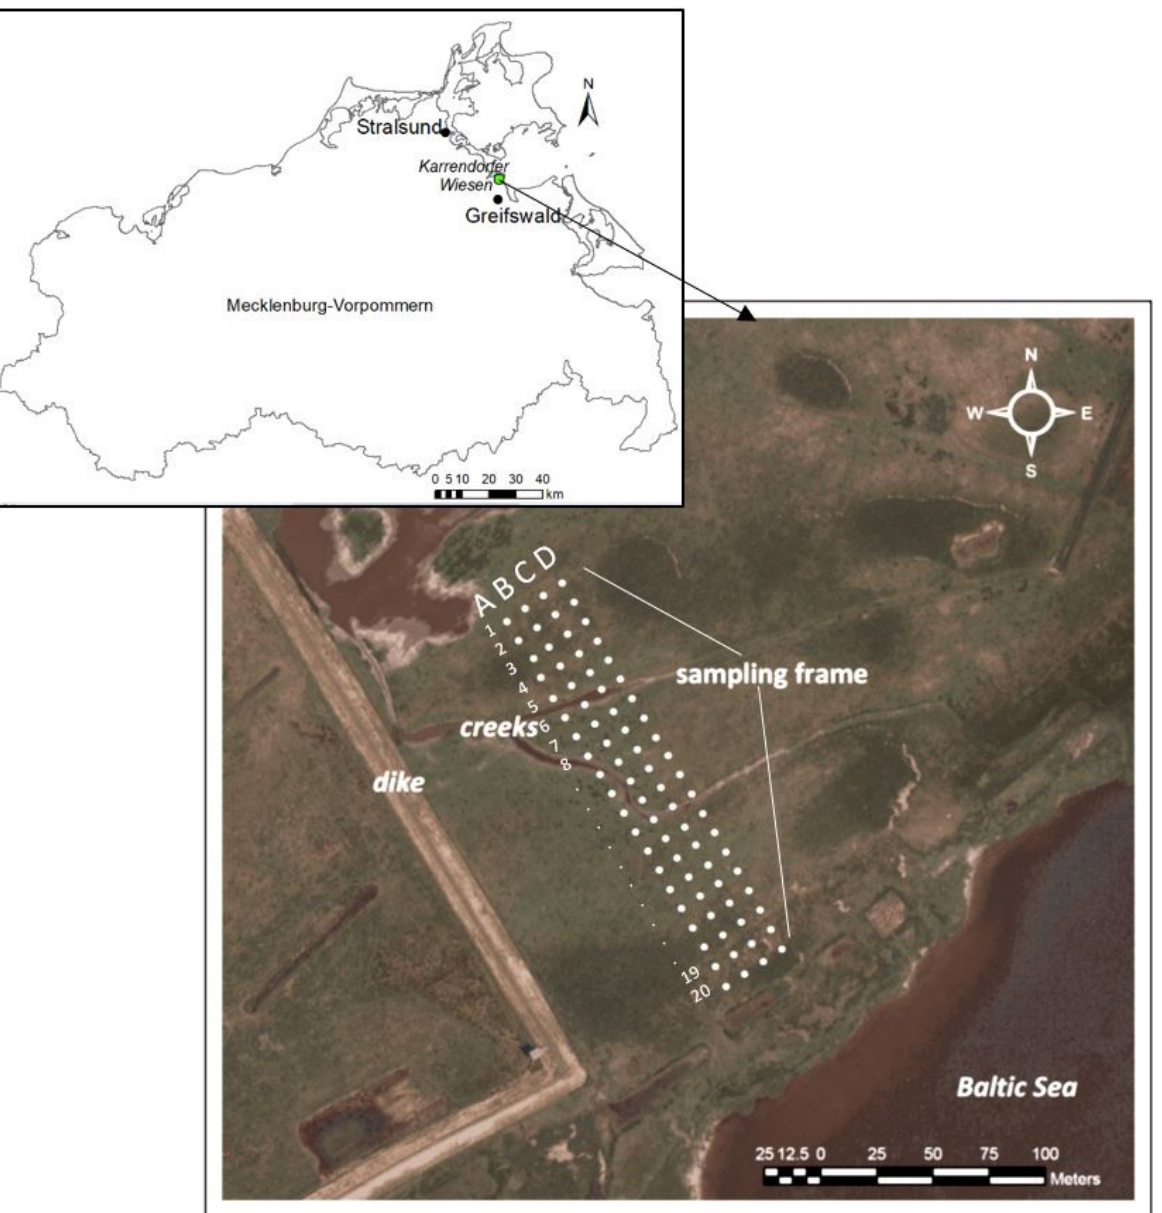
Figure 1. Location of the study area “Karrendorfer Wiesen”. The white dots on the map show the locations where soil samples were